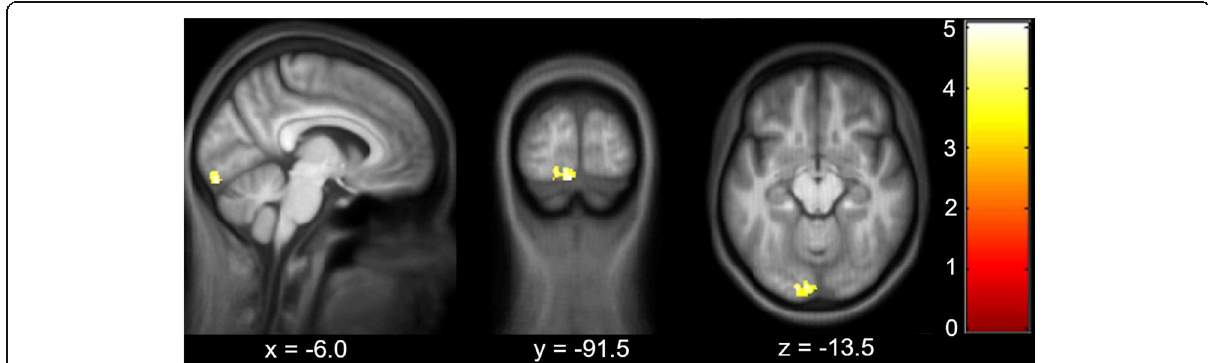
Fig. 2 Significant volumetric differences between migraine patients and healthy controls at baseline. Overlay of statistical parametric maps (uncorrected p < 0.001) shows increased cortical volume in patients versus controls in the left lingual gyrus. The color bar indicates the t-score